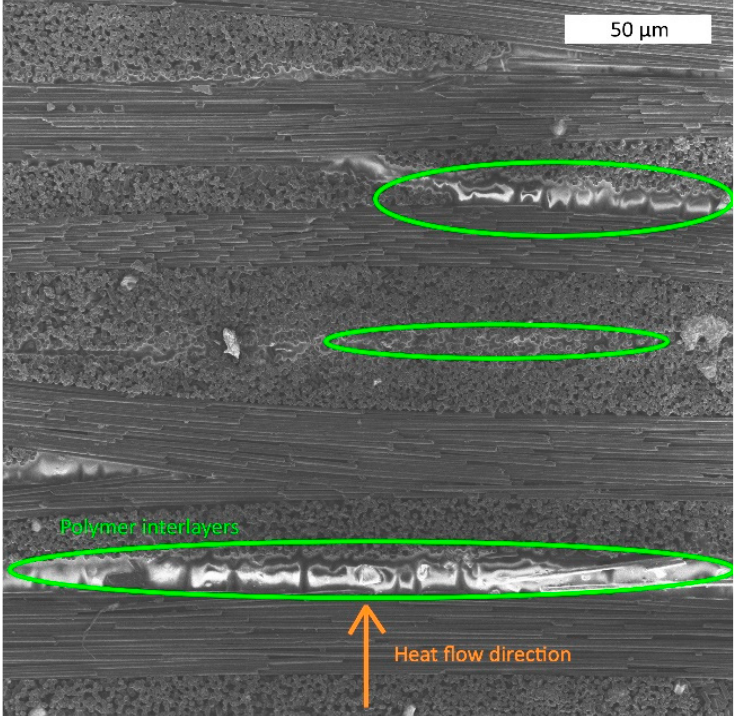
Figure 14. Scheme of heat flow distribution in the investigated composites for the 70/30 composite example.